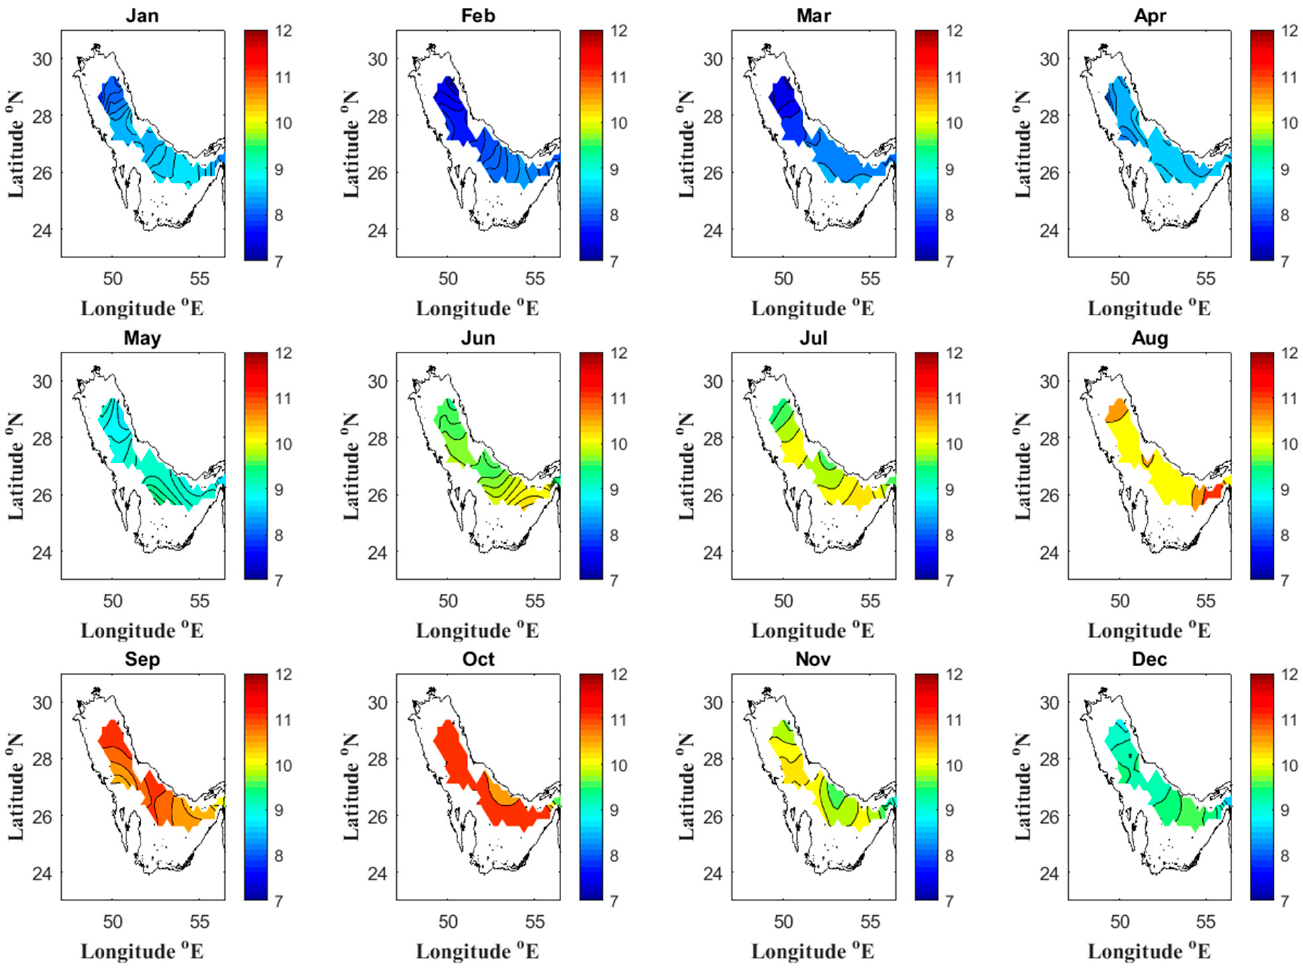
Figure 4. Heat content (×10 7 Jm − 2 ) for the water column to 35 m depth for every month.